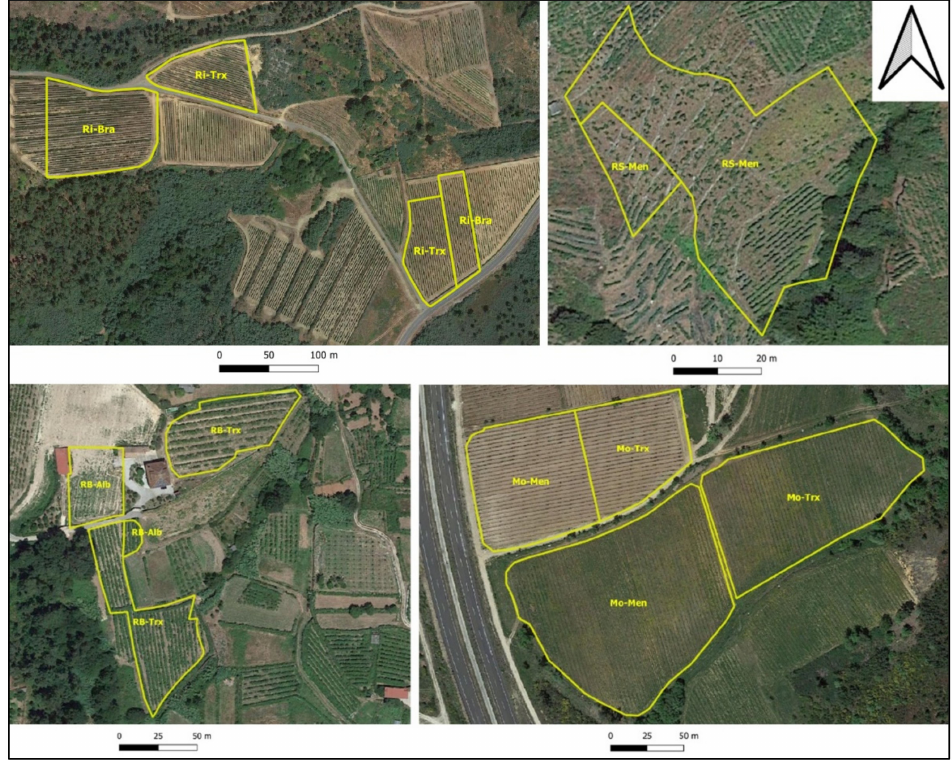
Figure 2. Commercial vineyards. Codes are shown in Table 1. Scales are different to ease visualization. Table 1. Characteristics of vineyards and grapevine cultivars used in this study. Average annual rainfall during the three years of the study, obtained from the closest weather station to each vineyard (MeteoGalicia). AOP: Appellation of Origin.